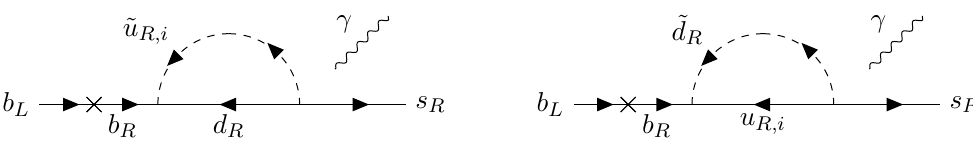
Figure 8. Diagrams for the (cid:13)avor-violating decay b photon can be attached to any charged line. Propagator arrows indicate the (cid:13)ow of baryon number.